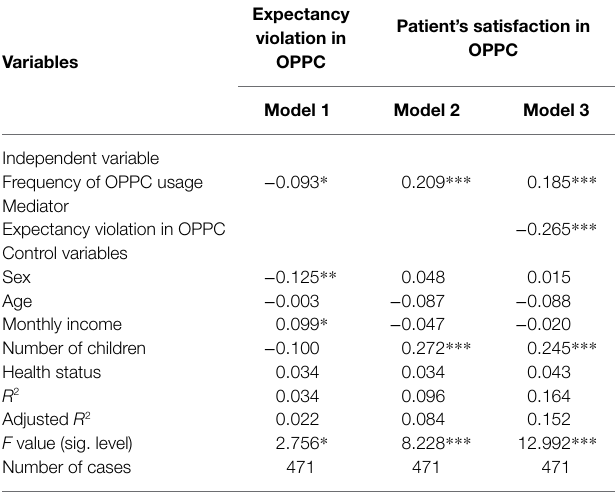
TABLE 3 | Hierarchical multiple regression analysis results in